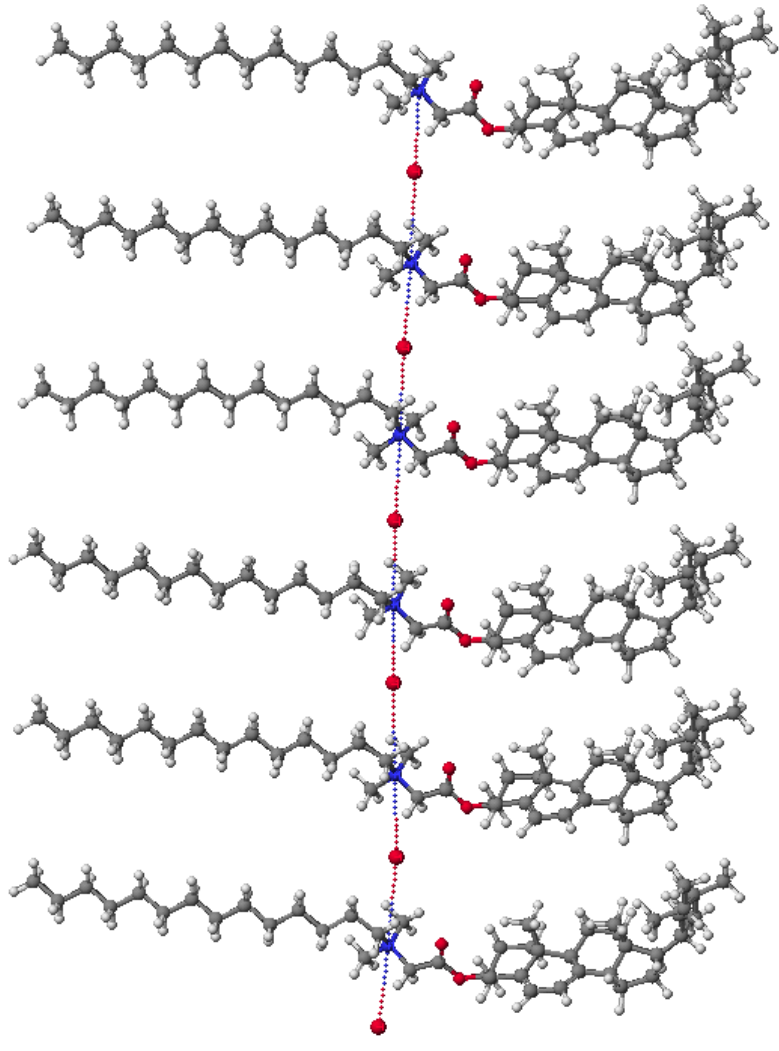
Figure 8. Molecular models of conjugates ( 10 ) calculated by PM5